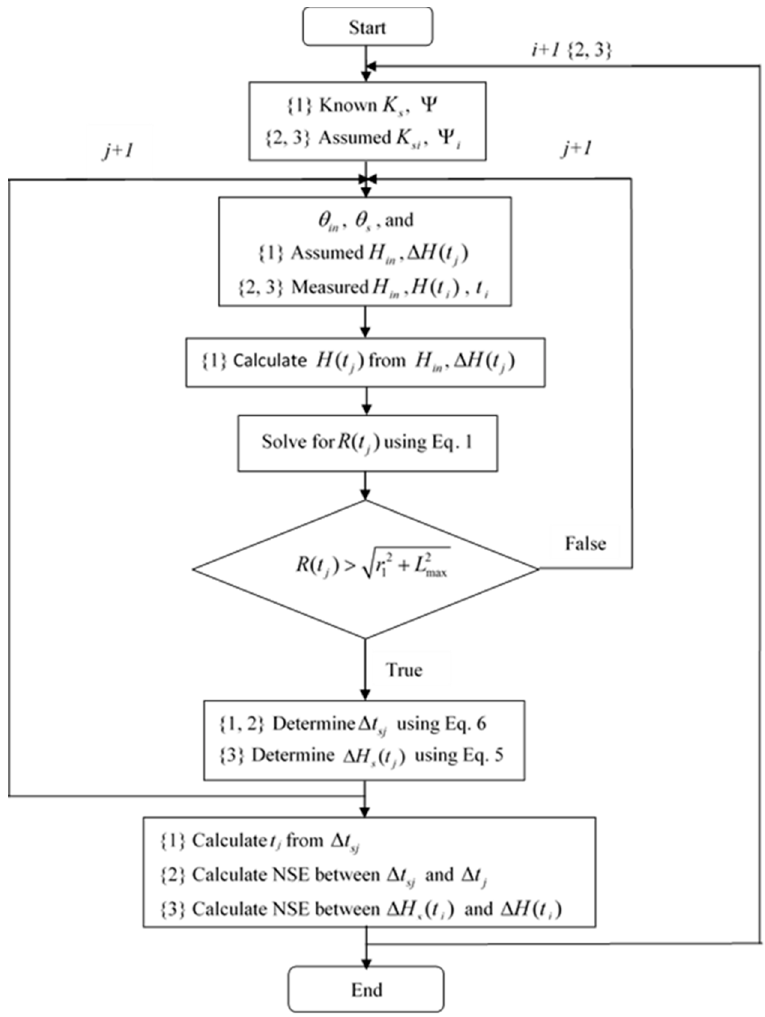
Figure 2. Flowchart for the analysis procedure using the forward-modeling code used to generate the drawdown data and to estimate K s and Ψ for values from measurements of head H ( t j ) versus time t j . Note: Between { } is the application number (e.g., Application 1, 2, and / or 3) that the corresponding parameter or a step is only used for that application/applications.